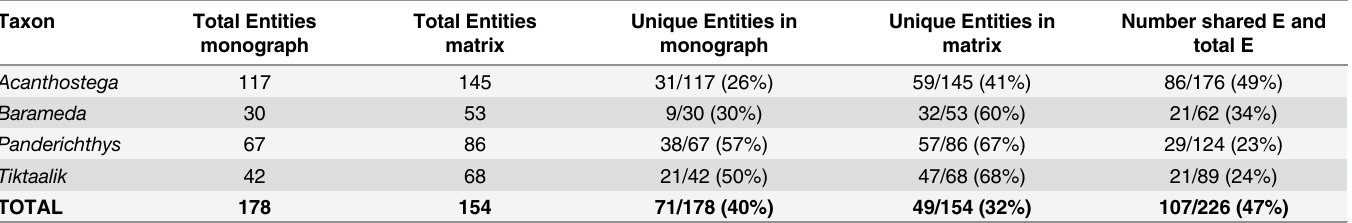
Table 4. Total number of girdle and limb anatomical entities, unique and shared, described in monographs vs. matrices for each of the study taxa.